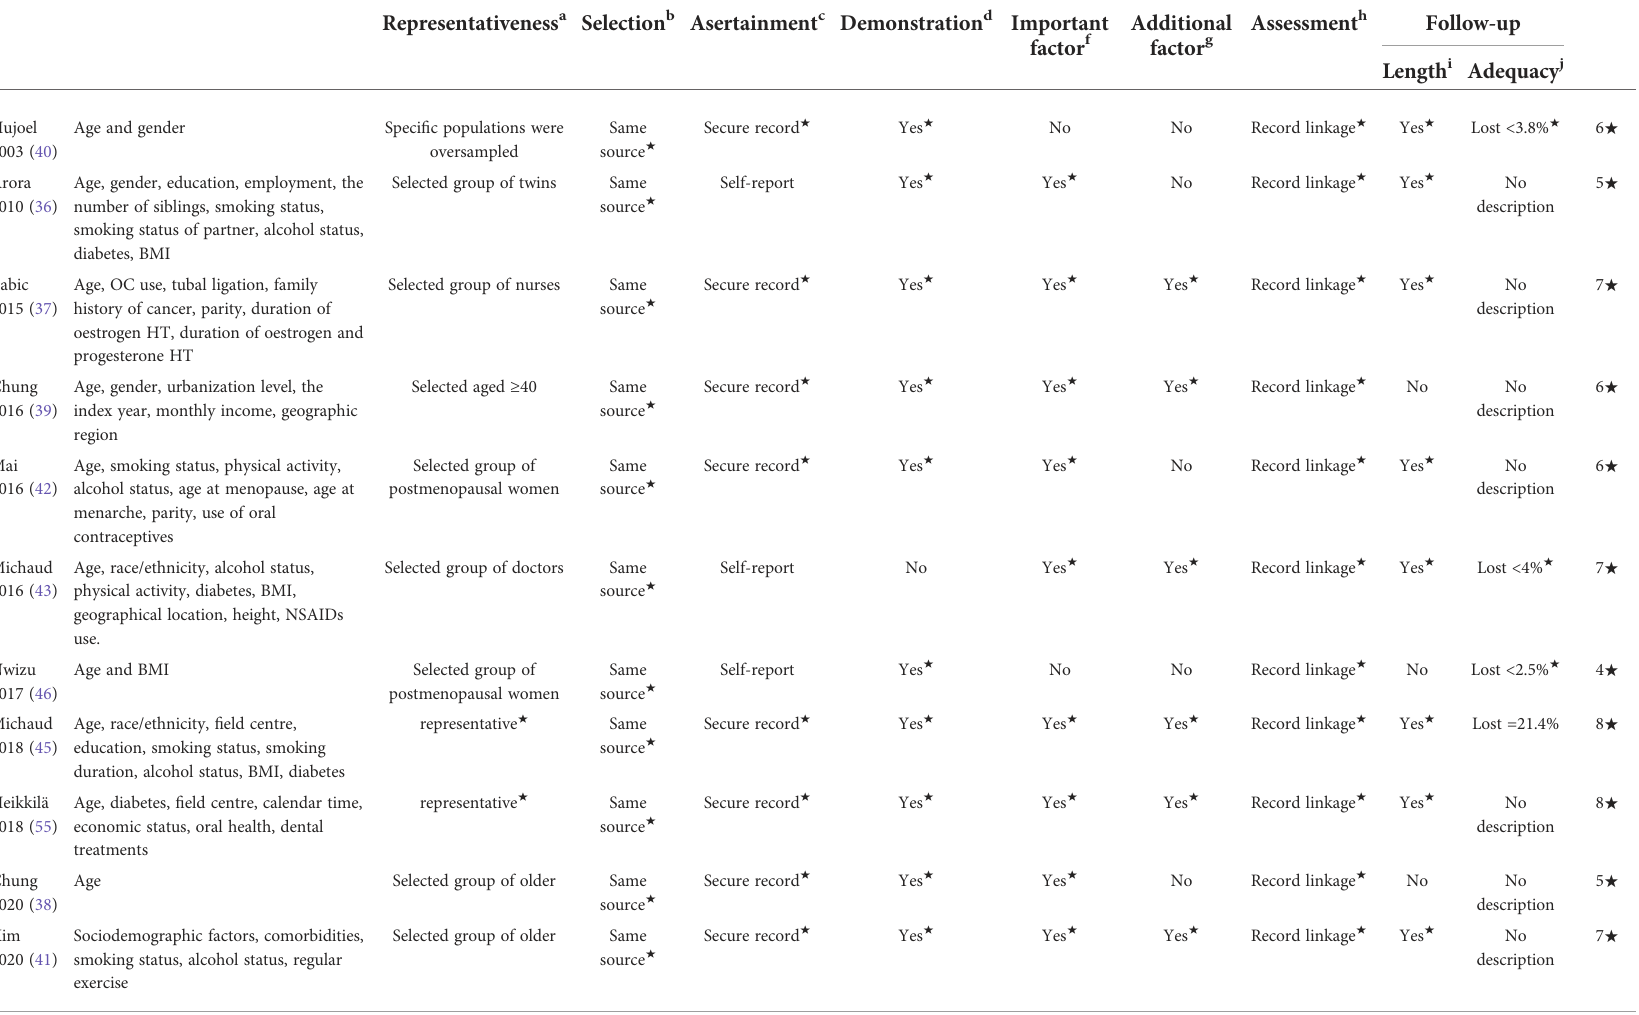
TABLE 2 The adjusted variables and Newcastle-Ottawa quality assessment scale for cohort